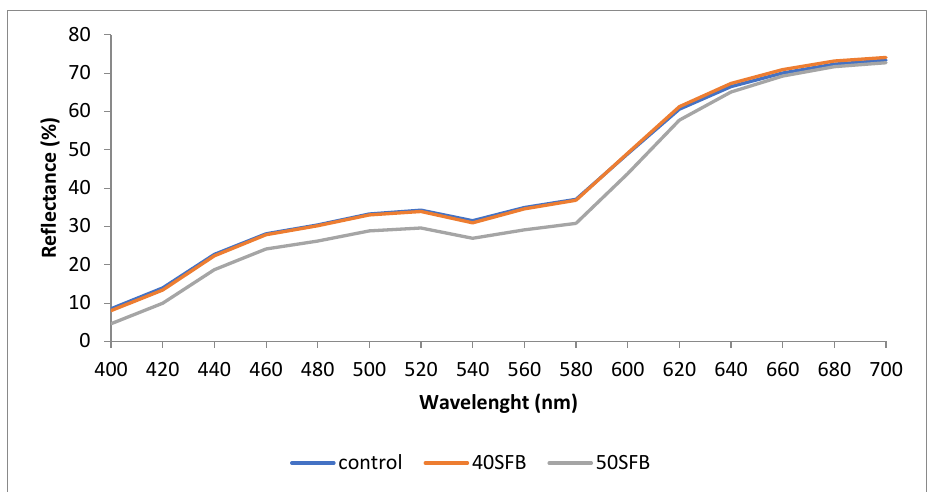
Figure 1. Reflectance spectra (360–740 nm) of chicken sausages [control, 40SFB (40% substitution of chicken skin by fatty byproducts and 50SFB (50% substitution of chicken skin by fatty byproducts)].